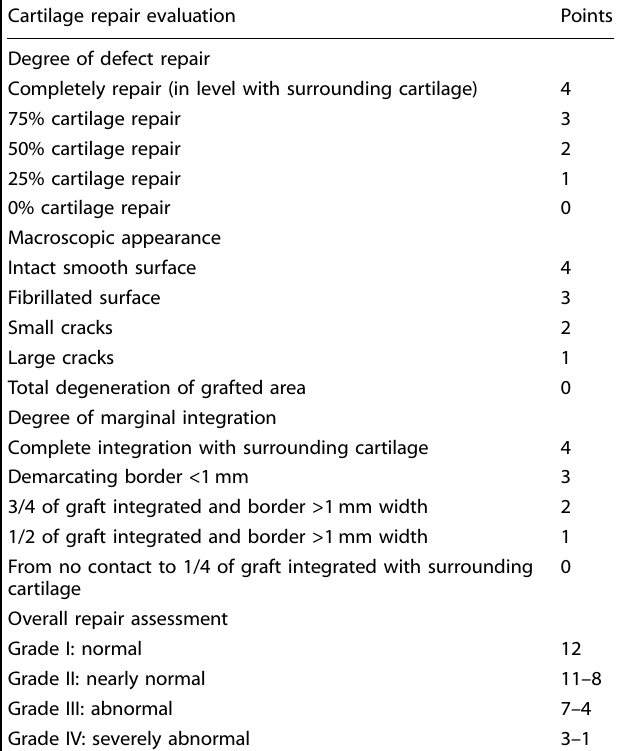
Table 4. ICRS macroscopic evaluation of cartilage